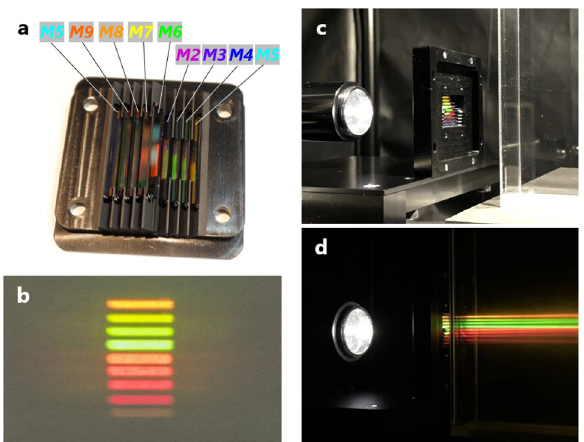
Figure 3. Fabricated ten-dichroic-mirror array and its demonstrations. ( a ) Fabricated ten-dichroic-mirror array. ( b ) Nine-color split images, with sizes of 1 mm × 7 mm, projected on a sheet of paper placed in front of the ten-dichroic-mirror array and illuminated by white light from behind. ( c ) Ten-dichroic-mirror array illuminated by white light from behind. ( d ) Nine-color split fluxes emitted from the ten-dichroic-mirror array, observed by placing a smoke-filled acrylic tank in front of the ten-dichroic-mirror array in c and darkening the room.